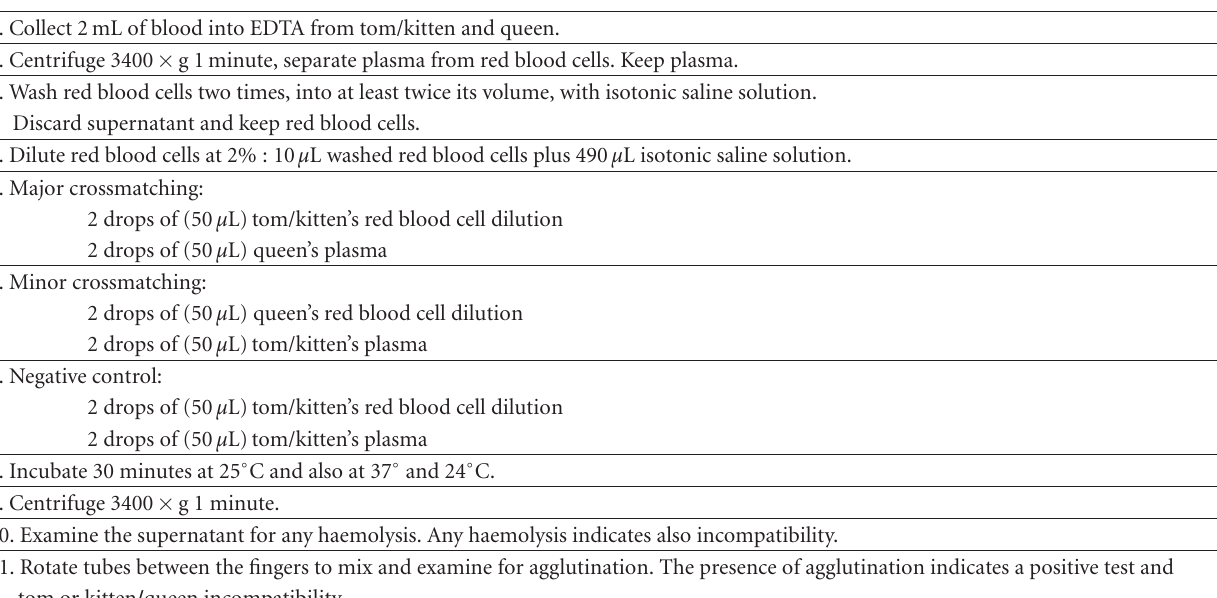
Table 5: Crossmatching protocol. Major crossmatching should be compatible at 37 ◦ and 24 ◦ C (cold agglutinins) and minor at 37 ◦ C (Adapted from Fox